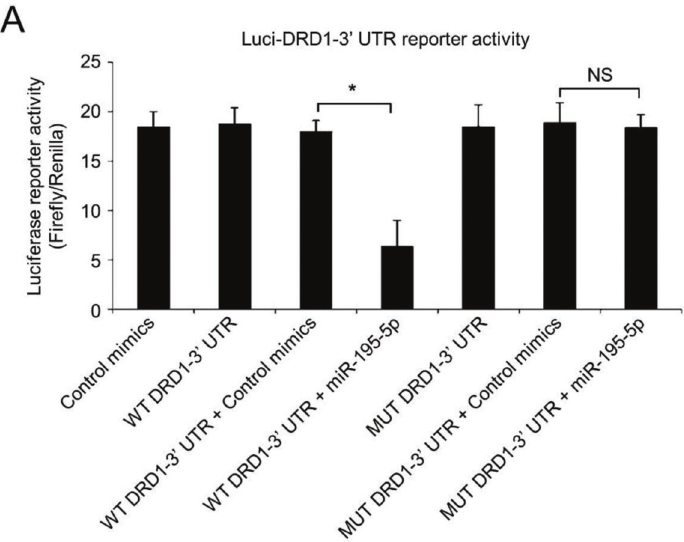
Figure S4 - Luciferase reporter assay to investigate the binding of miR-195-5p to the DRD1 3 0 -UTR. A Luciferase reporter activity indicating the inhibitory effect of miR-195-5p on DRD1 in HEK-293T cells transfected with DRD1-3 0 -UTR and DRD1-mut 3 ’ -UTR (MUT DRD1-3 0 UTR) and/or miR-195-5p mimic or control mimic for 24h. All values are shown as firefly/renilla ratio. All data are shown as the mean ± SEM (n=3), * p o 0.05; NS, not significant.